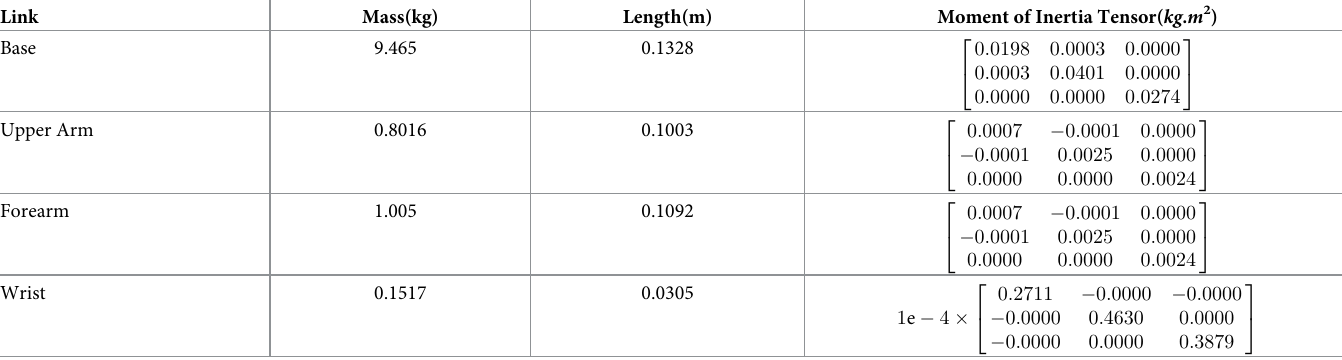
Table 1. Physical parameters of the SimMechanics/Simulink